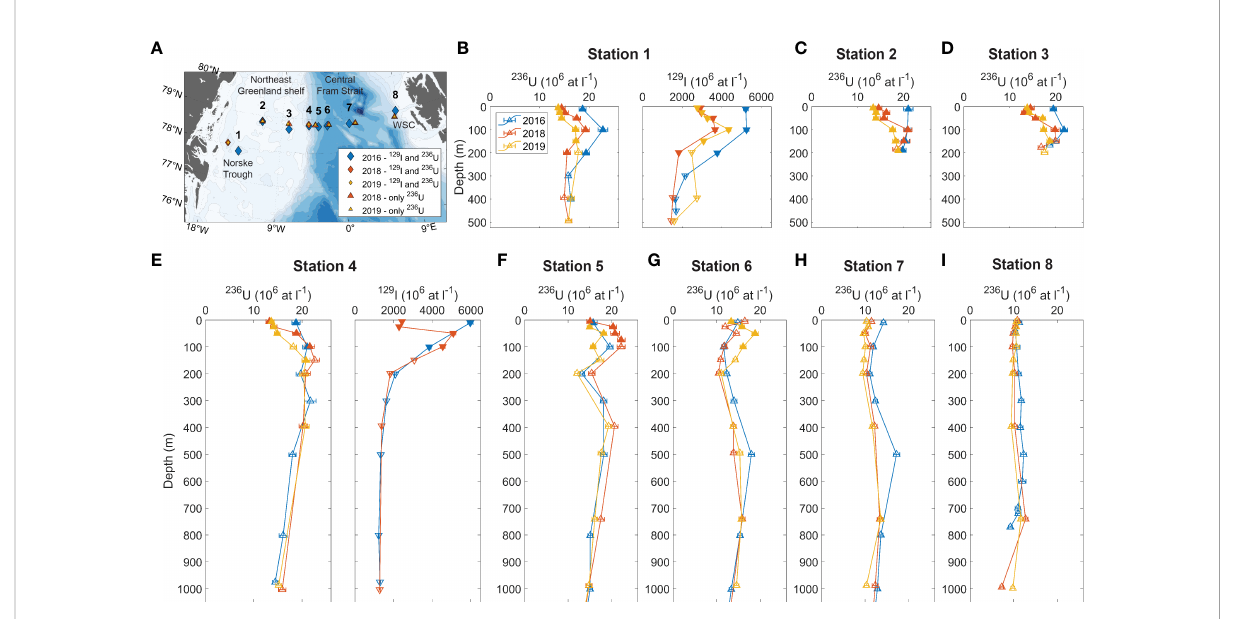
FIGURE 4 (A) Map showing locations of eight matching stations among the different expeditions. Colored diamonds show stations of available 129 I and 236 U data for 2016 (blue), 2018 (red) and 2019 (yellow). Colored triangles show stations where only 236 U data are available. (B – I) Pro fi les of 236 U (and 129 I for station 1 and 4) at matching stations 1-8 for 2016 (blue), 2018 (red), 2019 (yellow). Filled symbols indicate samples classi fi ed as PSW or